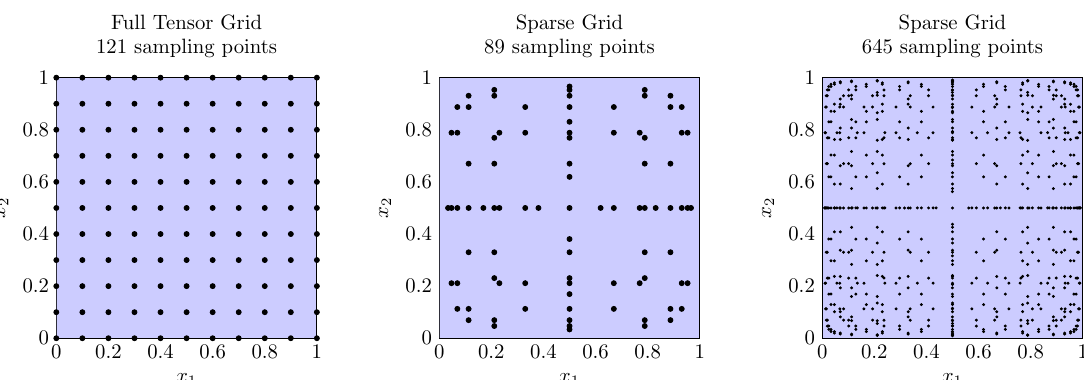
[ 0,1 ] using a full tensor grid and ×